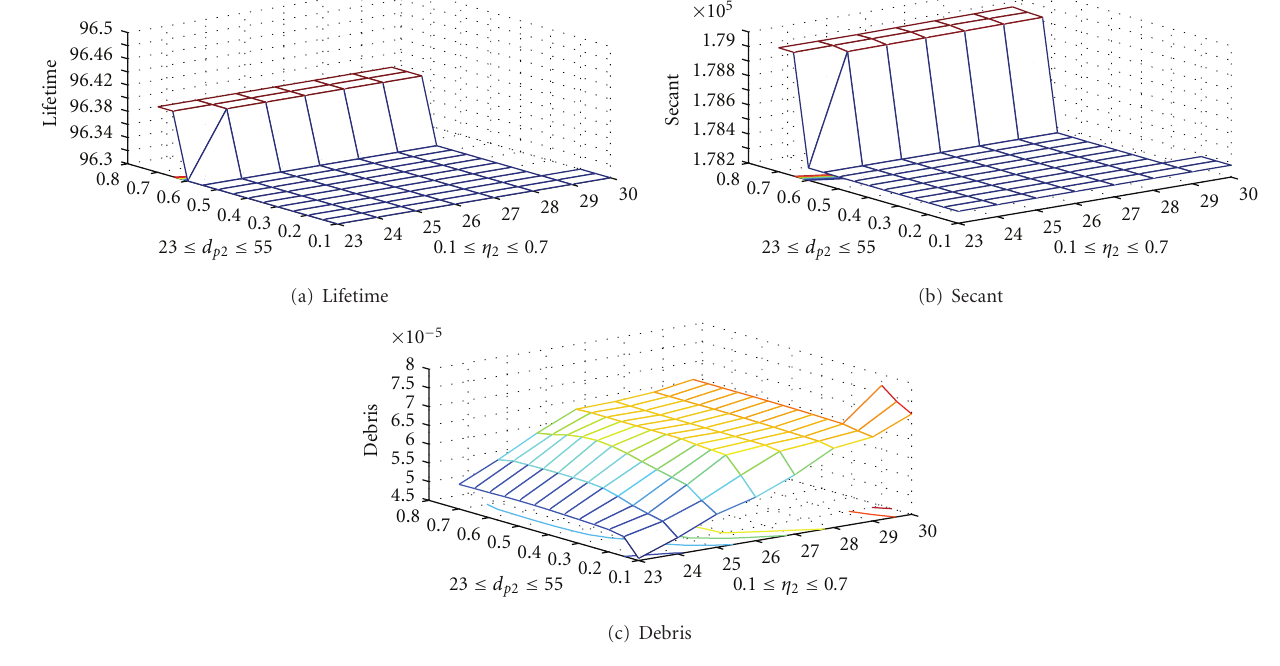
Figure 6: Landscapes with η 1 = 0 . 65, d p 1 = 38 μ m while η 2 , d p 2 vary. Table 1: The range of each parameter in each of its groups.